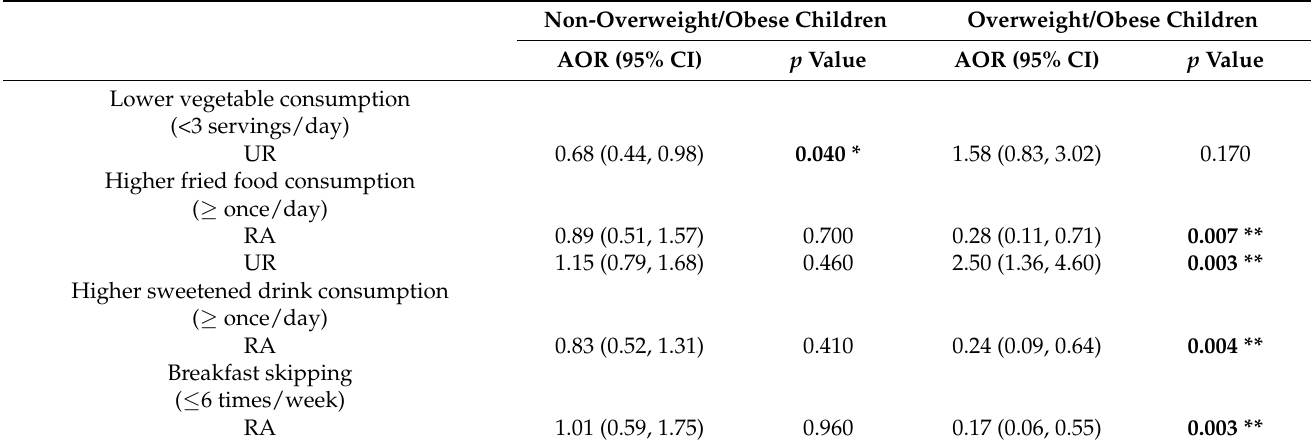
Table 5. Associations between parenting practices and children’s unhealthy behaviors after stratifica- tion by child body weight status. Non-Overweight/Obese Children Overweight/Obese Children AOR (95% CI) p Value AOR (95% CI) p